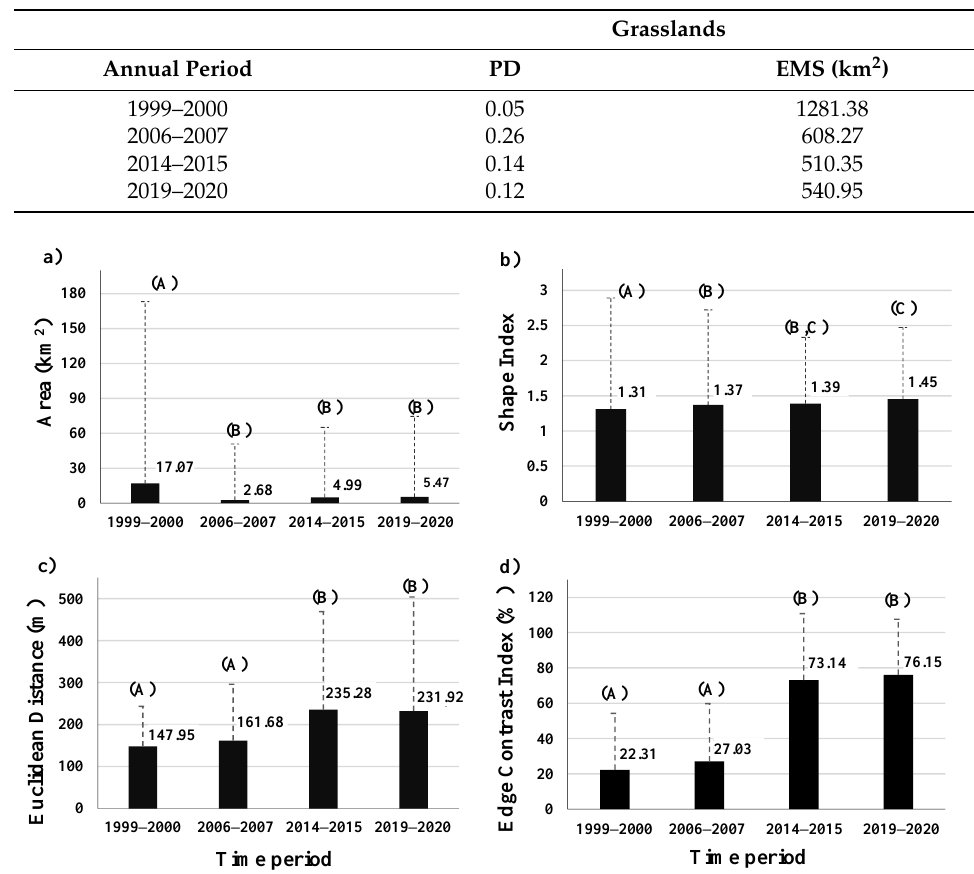
Figure 5. Mean values for each grassland landscape metric at patch level, ( a ) PS, ( b ) SHAPE, ( c ) ENN, ( d ) ECON; vertical bars represent the standard deviation. Significant differences between time periods based on Kruskal Wallis test is represented by different letters ((A), (B), (C)) (see Appendix C for the Kruskal Wallis tests